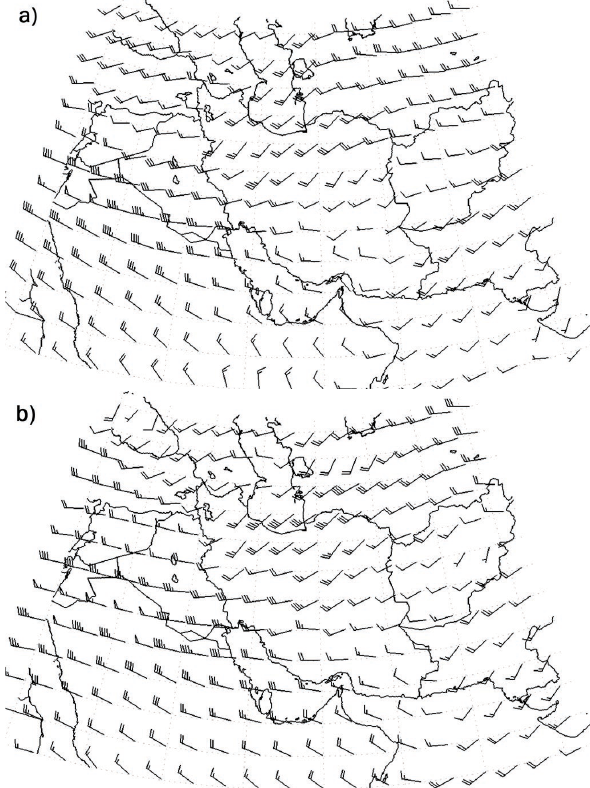
Fig. 7. (a) 300hPa chart on 30 April 2009 at 00:00UTC. (b) 300hPa chart on 30 April 2009 at